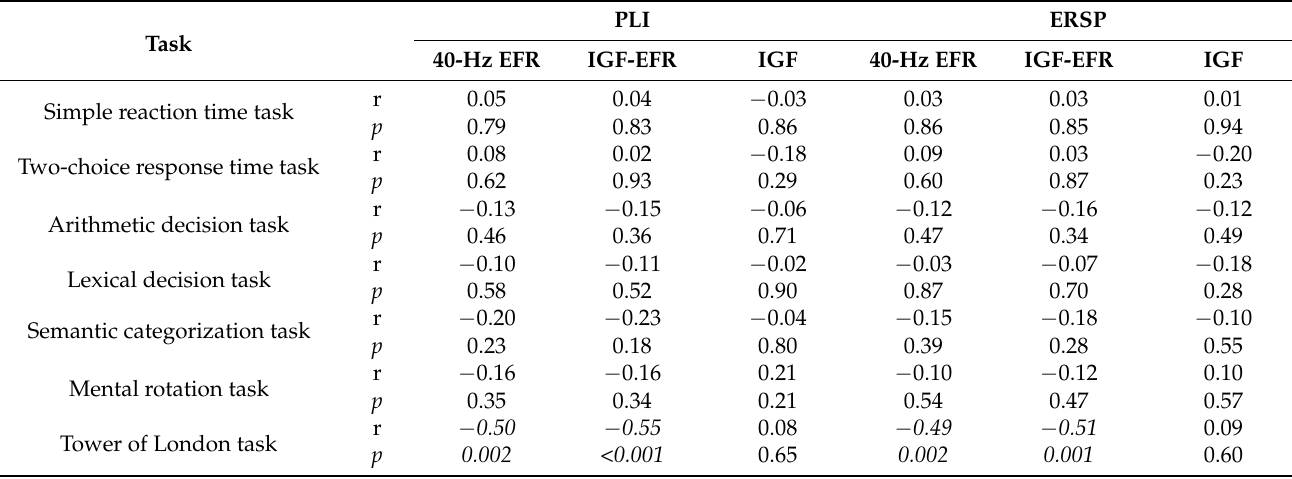
Table 3. Correlation coefficients and corresponding p -values for correlations between envelope following response measures and response times on cognitive tasks.